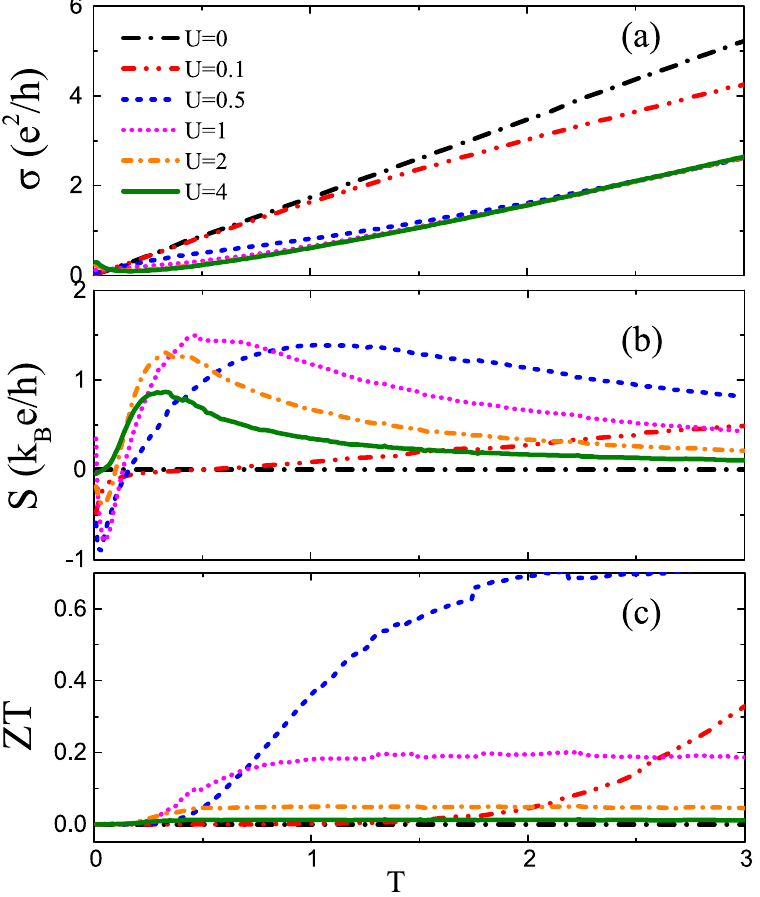
Figure 3. ( a – c ) The electric conductivity σ , the thermopower S , and the figure of merit ZT , respectively, at the Fermi level μ = 0 as a function of temperature T for various impurity potential U as indicated. The other parameters are the same as in Fig.